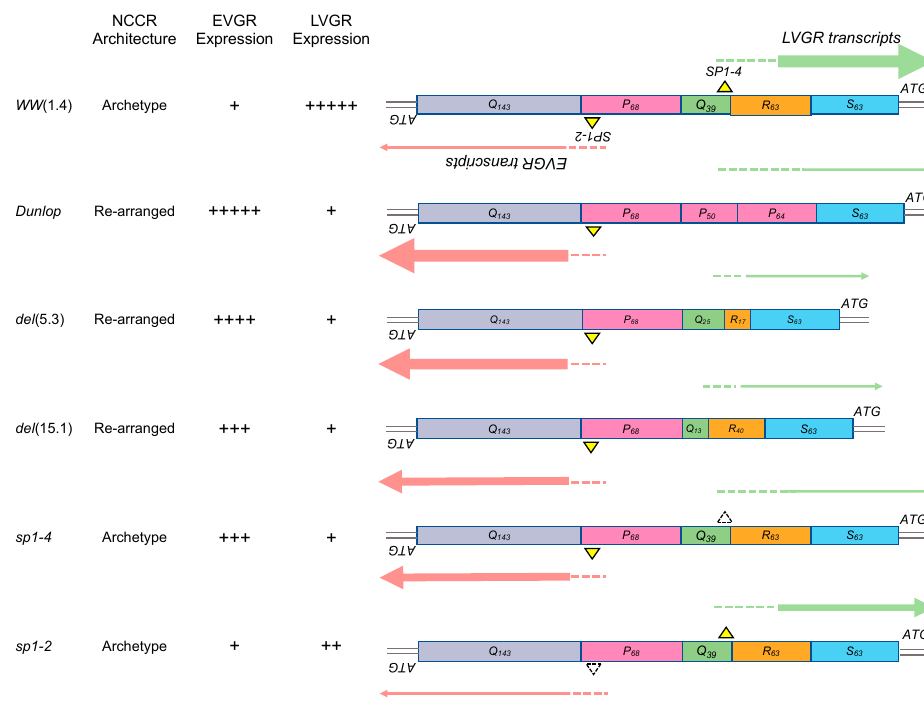
Figure 1. Schematic representation of NCCR architecture and EVGR and LVGR expression pattern of BKPyV strains. BKPyV NCCR architecture, Sp1 binding sites and expression levels are schematically